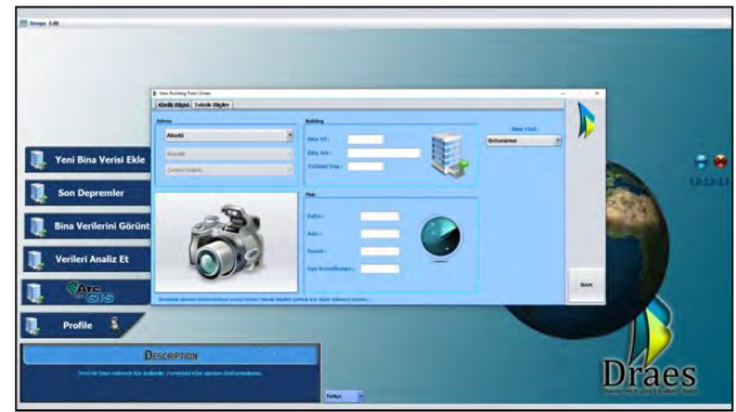
Figure 7. New Building Data - Identity Information